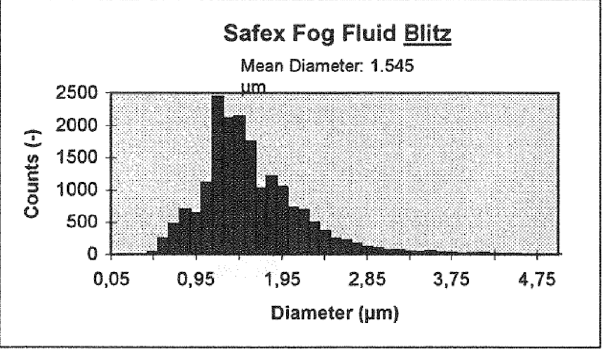
Figure A4. Size distribution of droplets (measurements with DANTEC PDA).